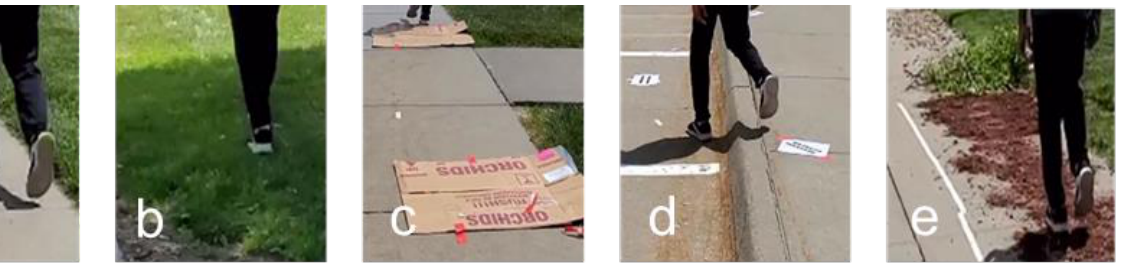
Figure 3. Good and typical irregular walking surfaces: ( a ) Good, well-paved; ( b ) Grass-covered (Irregular); ( c ) Obstructions (Irregular); ( d ) Uneven (Irregular); and ( e ) Debris-covered (Irregular).